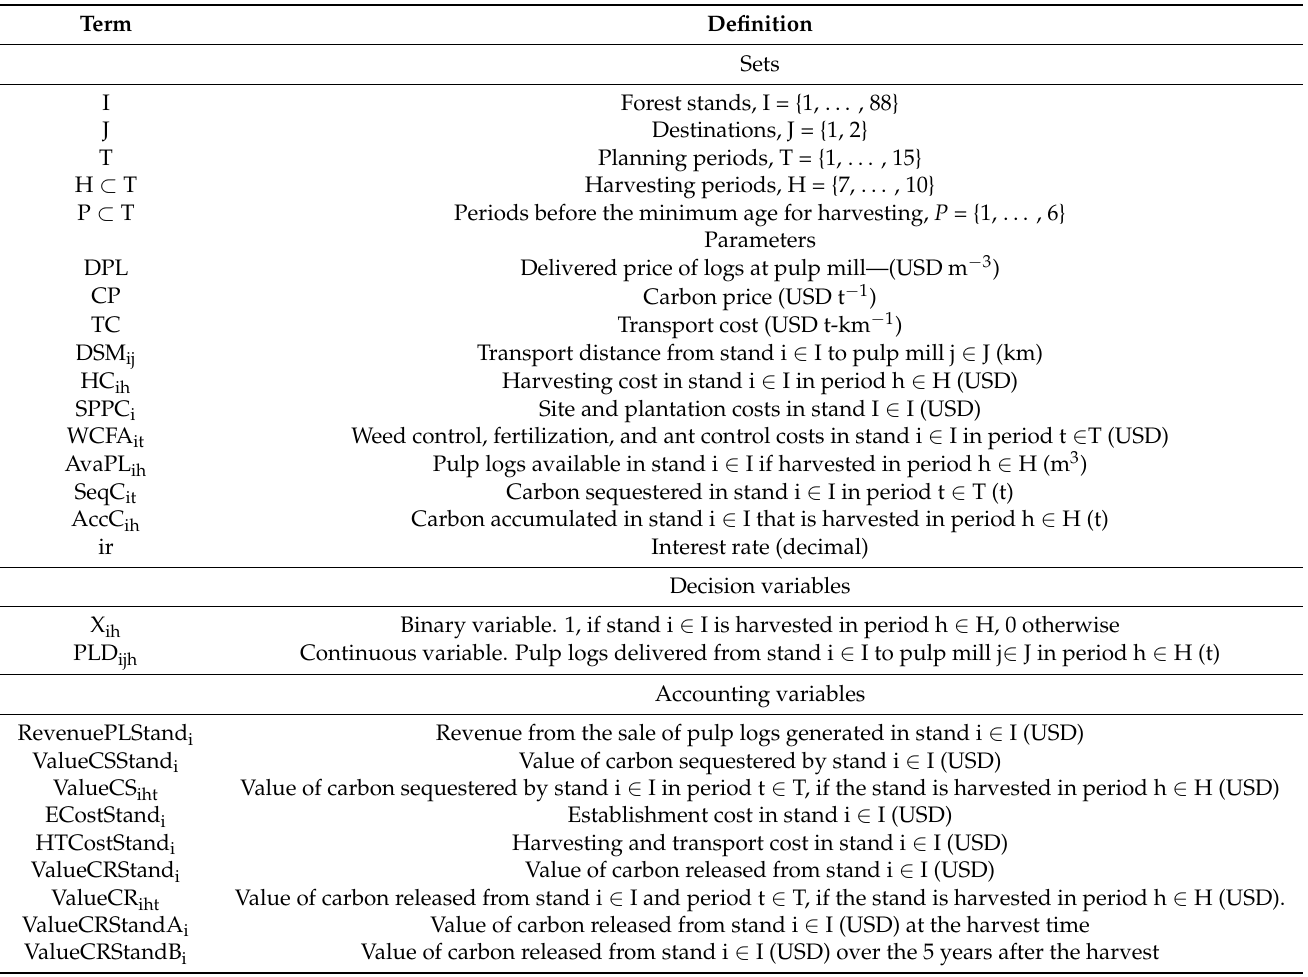
Table 2. Sets, parameters, and variables of the thinning optimization